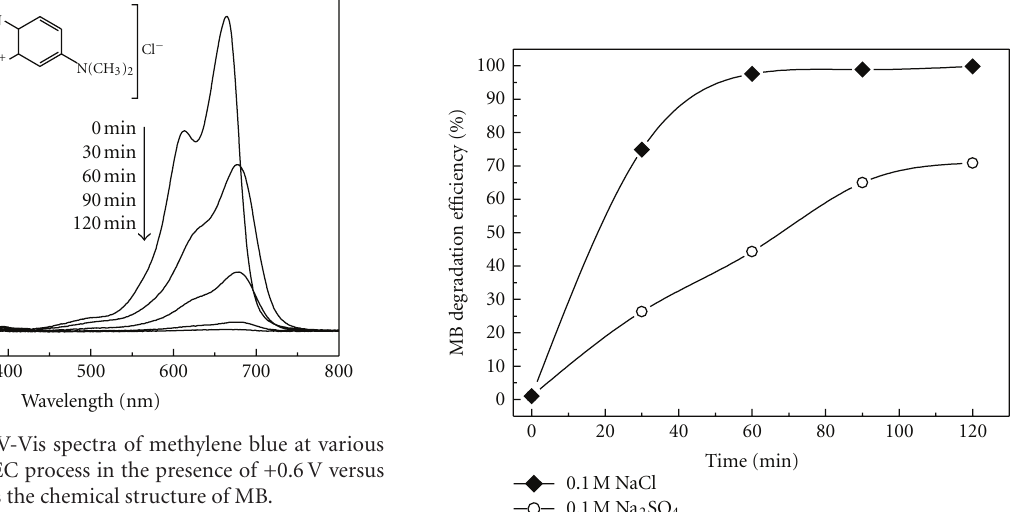
Figure 7: MB degradation kinetic curves of TiO 2 nanotube array under various conditions.